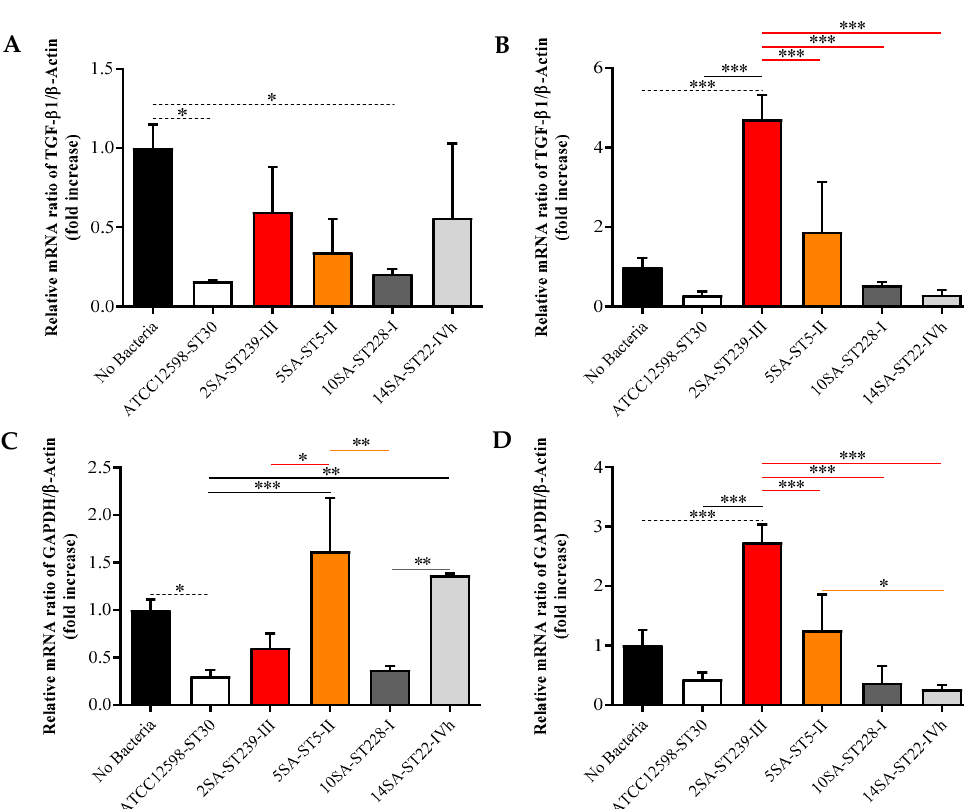
Figure 4. Gene expression of transforming growth factor beta 1 (TFG ‐β 1) ( A , B ) and glycolytic enzyme glyceraldehyde 3 ‐ phosphate dehydrogenase (GAPDH) ( C , D ) in uninfected (No Bacteria) MG ‐ 63 osteoblast ‐ like cells and in MG ‐ 63 cells infected at an MOI of 100:1 with five different S. aureus strains detected at 3 and 24 h. The abundance of each mRNA is expressed relative to the abundance of β‐ actin ‐ mRNA. Values are means ± SD of three independent experiments. Significant comparisons between each experimental condition are indicated by lines. * Significantly different, p < 0.05; ** significantly different, p < 0.01; *** significantly different, p < 0.001.